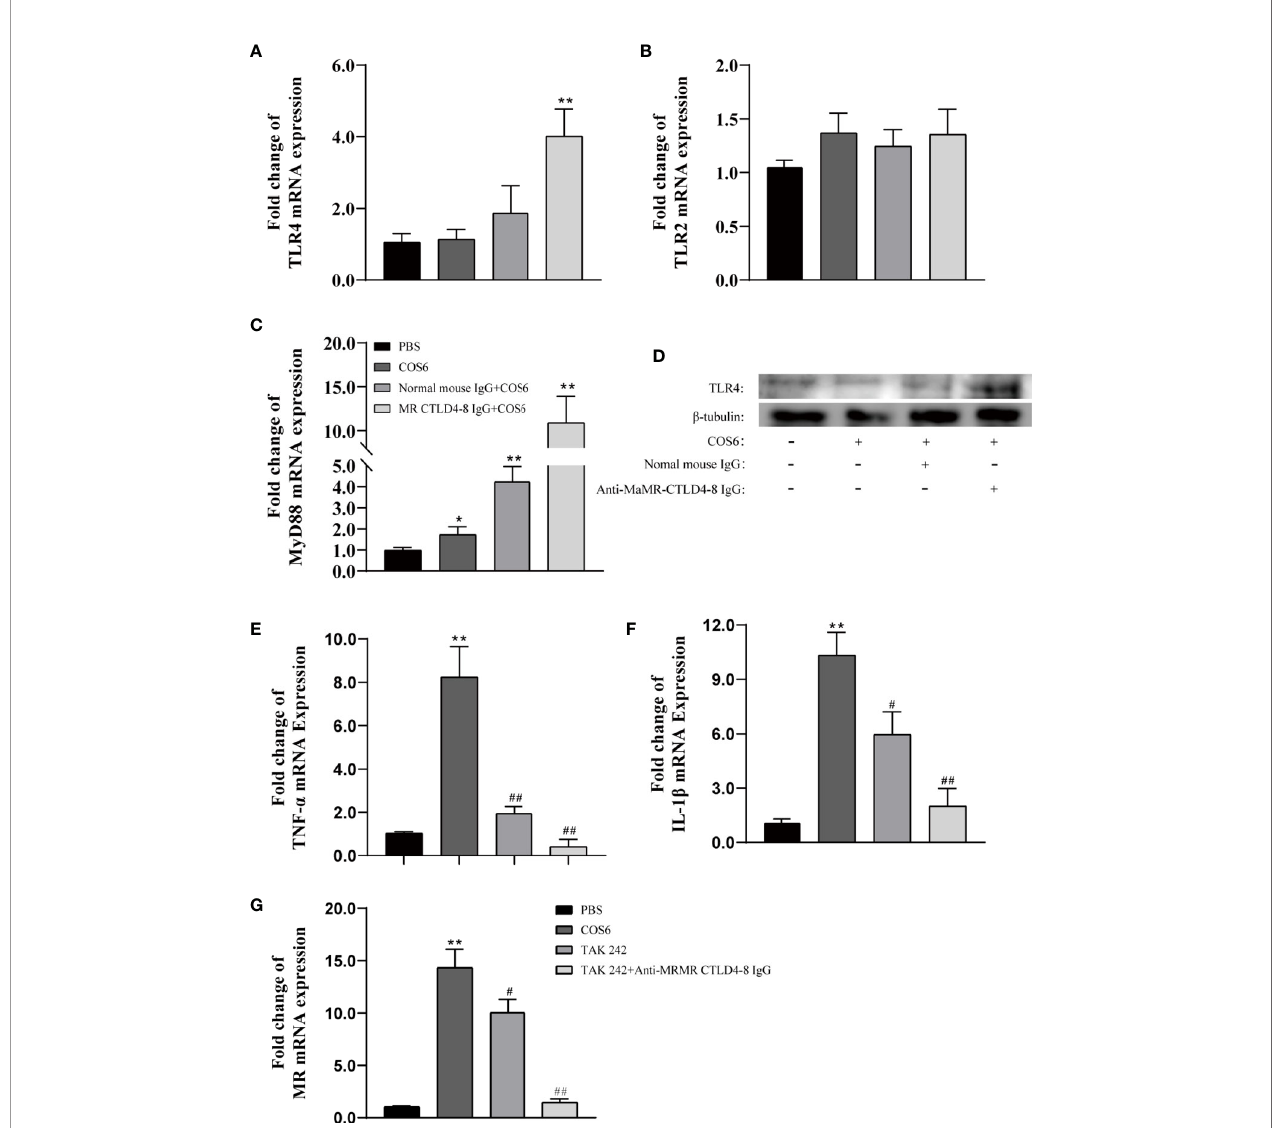
FIGURE 6 | The expression of Toll-like receptor (TLR)2/4, mannose receptor (MR), and in fl ammation-related genes in chitooligosaccharide hexamer (COS6)- stimulated macrophages with or without blocking. (A) TLR4, (B) TLR2, (C) MyD88, (D) Western blot analysis of TLR4 and TLR2, (E) tumor necrosis factor (TNF)- a , (F) interleukin (IL)-1 b , (G) MR. Western blot analysis using anti-TLR4, anti-TLR2 antibodies, and anti- b -tubulin antibody was used to evaluate the quantity of proteins in each lane. TLR2 has no signi fi cant difference; the data are not shown. Each experiment was executed in triplicate. Data were shown as means ± SD (n = 3), with (*) p < 0.05 and (**) p < 0.01 vs. the phosphate buffered saline (PBS) group, ( # ) p < 0.05 and ( ## ) p < 0.01 vs. the COS6 group (set as